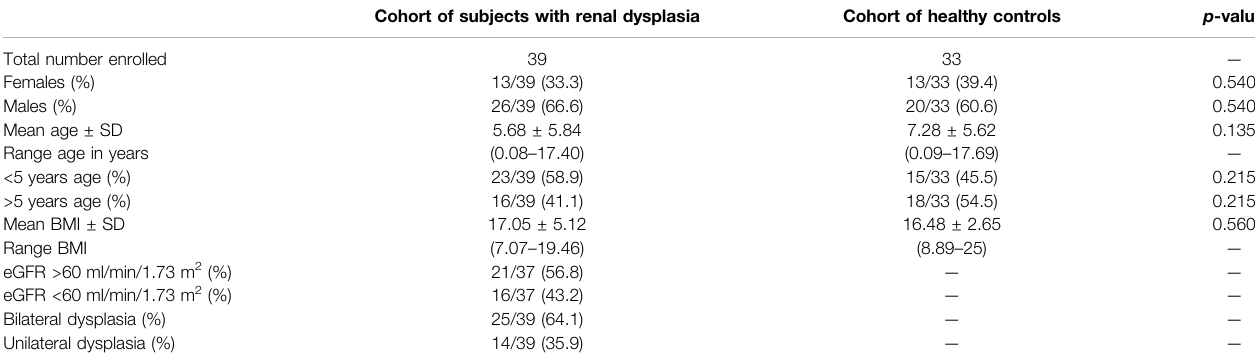
TABLE 1 | Clinical features of the studied cohorts of 72 children (39 with renal dysplasia and 33 healthy controls). Cohort of subjects with renal dysplasia Cohort of healthy